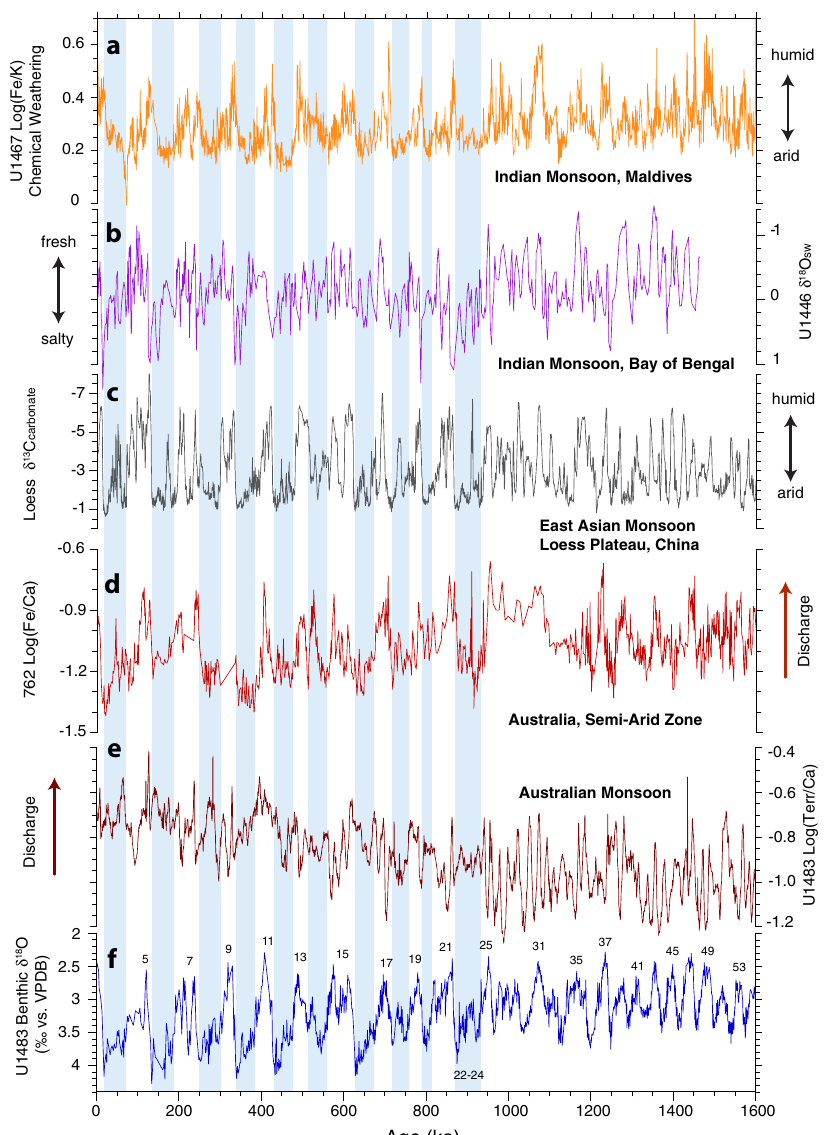
Fig. 7 | Comparison of proxy records for Indian, East Asian, and Australian SummerMonsoonoverthepast1.6Myr.a ChemicalweatheringproxyLog(Fe/K) from Site U1467 64 . b Salinity proxy δ 18 O sw from Site U1446 63 . c Precipitation proxy (carbonate δ 13 C)fromChineseLoessPlateau 65 . d Riverinedischargeproxy(Log(Fe/